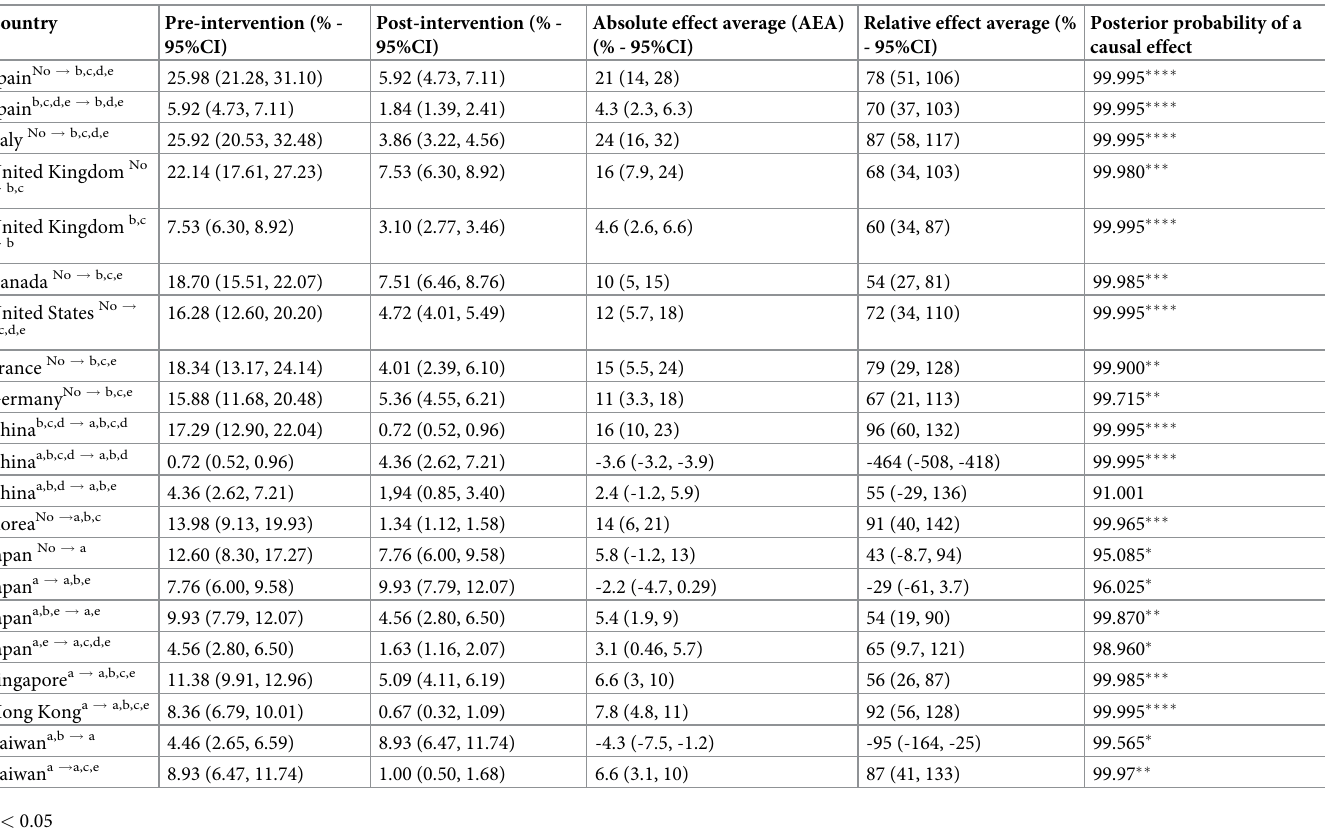
Table 2. Decreasing new case indices of countries by intervention